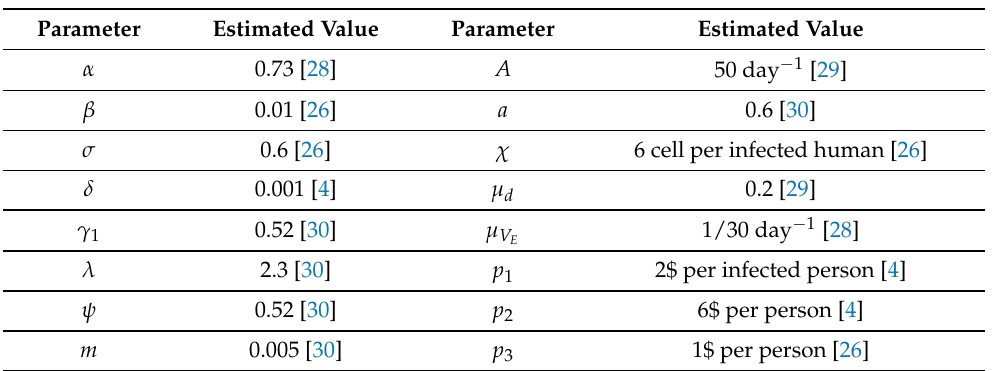
Table 1. Parameter